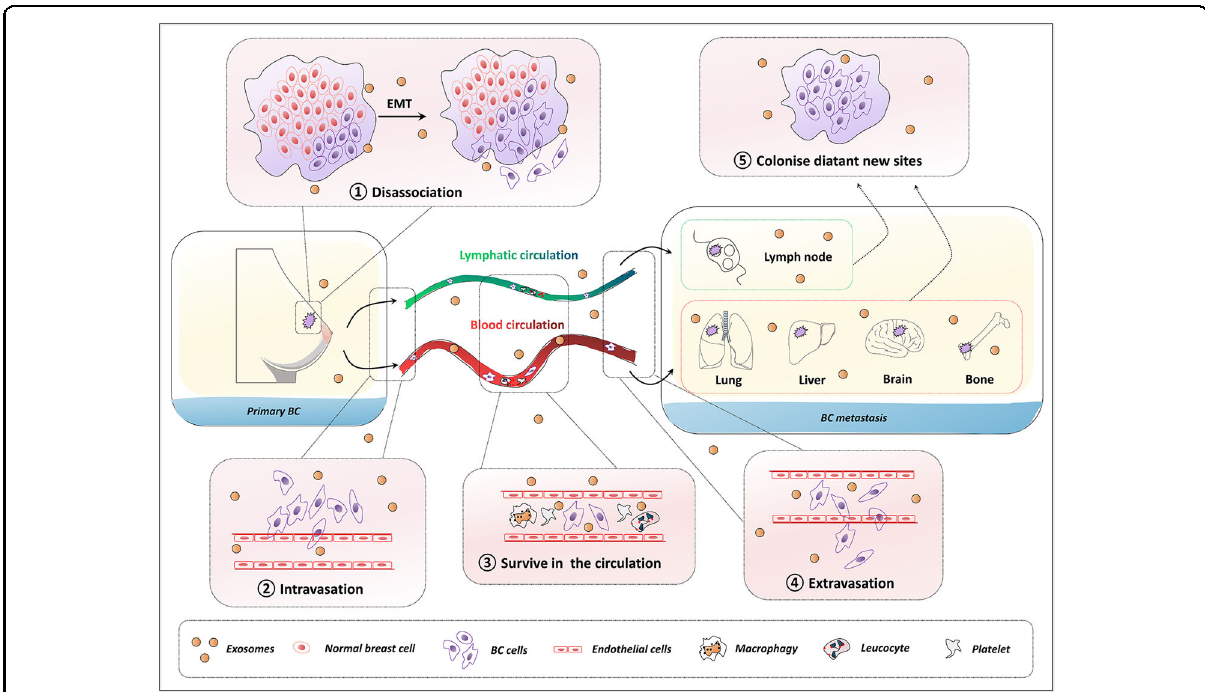
Fig. 2 The general multistep process of BC metastasis and exosomes act as regulatory factors. Metastasis is a multistep process by which the primary BC cells undergo epithelial – mesenchymal transition (EMT) and dissociate from the initial site, intravasation, survival in the blood or lymphatic circulation, extravasation, and ultimately colonize distant sites. Exosomes from BC cells are crucial orchestrators to condition the pre-metastatic niche microenvironment in metastatic progression. Breast cancer BC, epithelial – mesenchymal transition